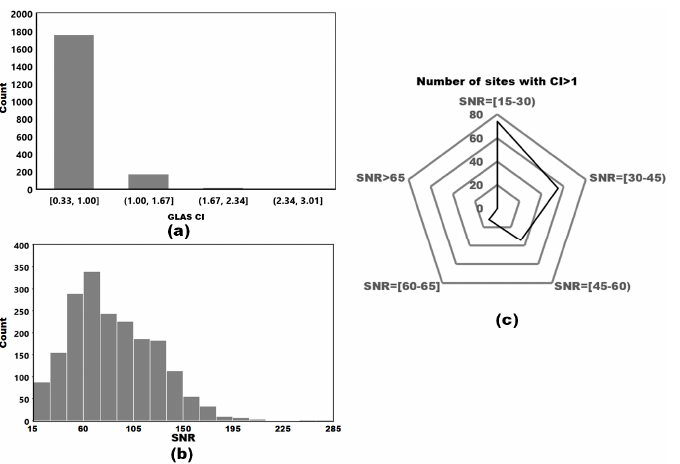
Figure 9. ( a ) The GLAS CI distribution in Heilongjiang Province. ( b ) The SNR (i.e., signal-to-noise ratio = i_maxRecAmp/i_sDevNsObl) distribution of GLAS data in Heilongjiang Province. ( c ) The relationship between unreasonable CI values and SNR, the number of unreasonable CI values gradually decreases as the signal quality improves; when SNR > 65, the unreasonable CI values